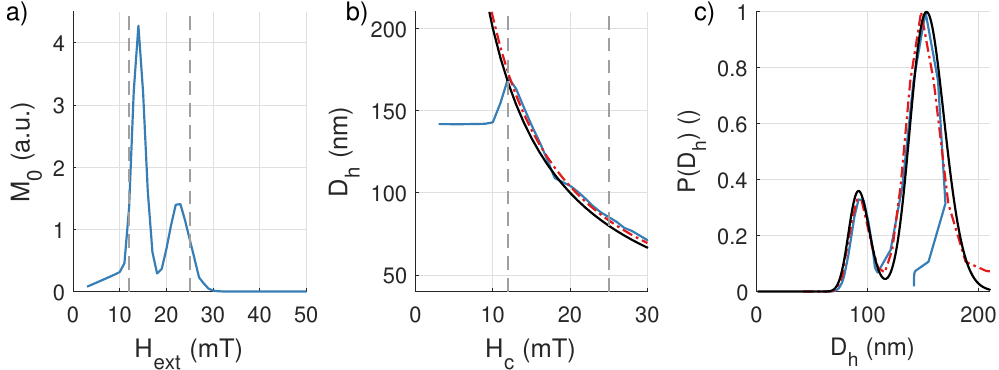
Figure 8. ( a ) Initial particle response ( M 0 ) at the end of the excitation. The dashed lines show the subset of measurements for which the signal is larger than 25% of its maximum value. ( b ) Extracted D h by fitting an exponentially decaying curve to each MRX measurement. The blue line corresponds to the extracted particle size of the MRX measurements, the black line is the actual coercivity–size relation and the red dash-dotted line represents the fitted coercivity–size relation based on the measurement values (in blue) between the two dashed lines. ( c ) The black line represents the actual particle size distribution, the blue line is the extracted size distribution based on all the measurements, and the red dash-dotted line is the found distribution using the fitted relation between size–coercivity for only part of the measurement